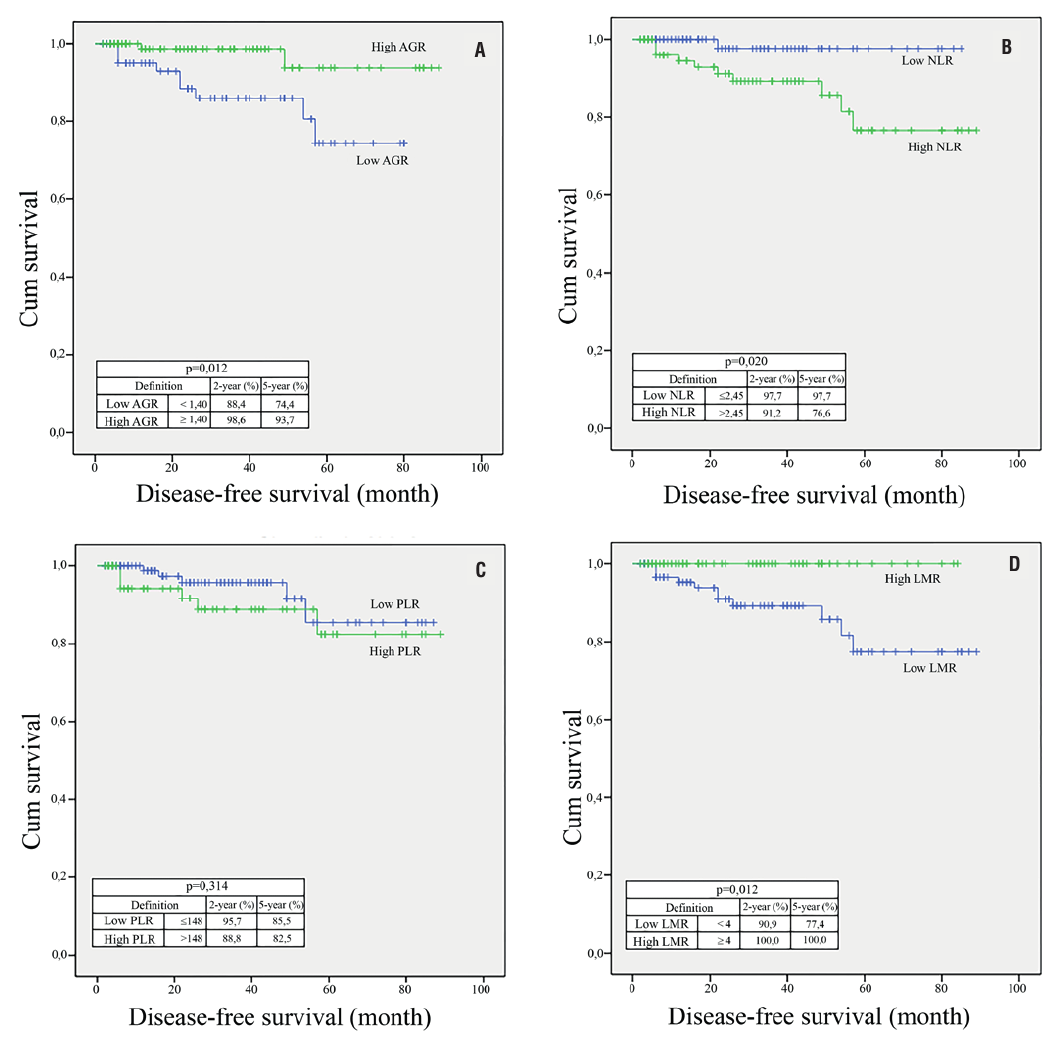
Figure 4 - Kaplan–Meier curves predicting disease-free survival, and 2 and 5-year disease-free survival probability, groups categorized by the pretreatment (A) albumin / globulin ratio (AGR), (B) neutrophil / lymphocyte ratio (NLR), (C) platelet / lymphocyte ratio (PLR), and (D) lymphocyte / monocyte ratio